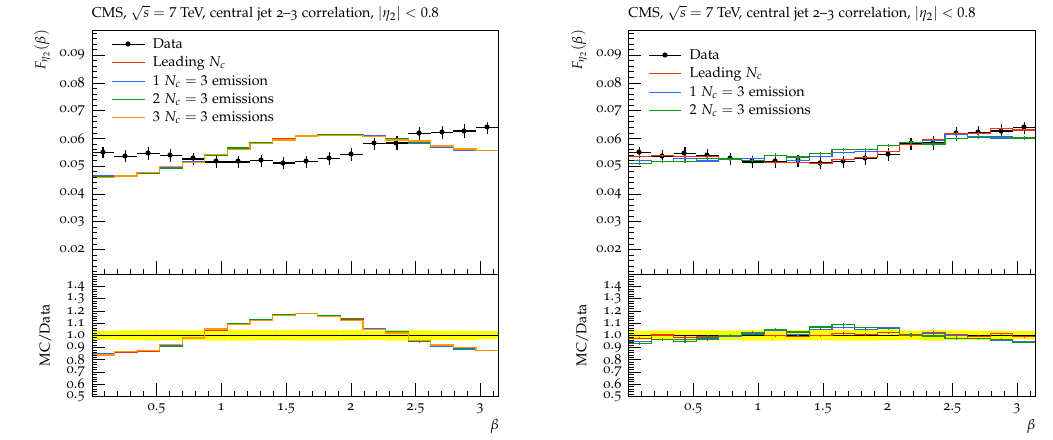
2 hard process and !